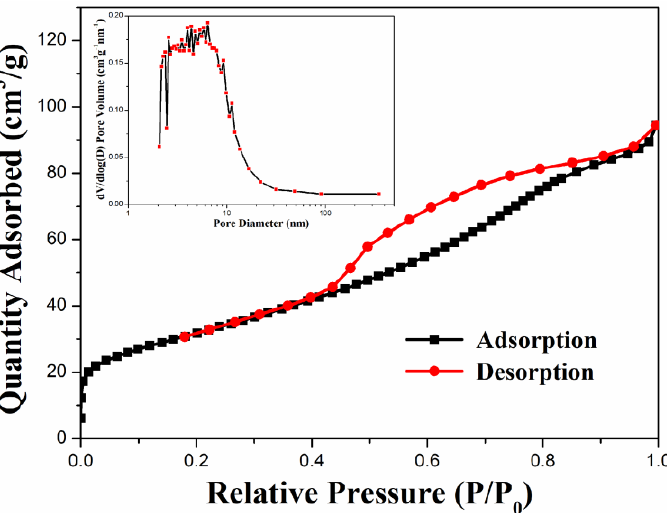
Figure 5. N 2 adsorption–desorption isotherm of ZFG and pore size distributions calculated from the BJH model.